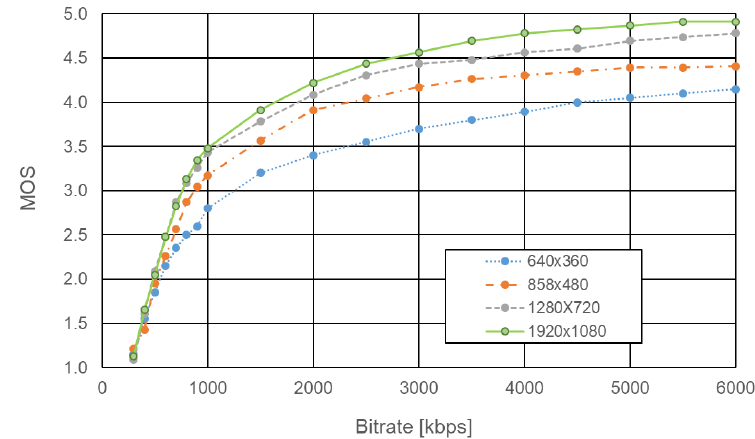
Figure 8. Results of the subjective quality assessment (MOS) for the H.265-encoded video as a func- tion of bit rate for different spatial resolutions—measurements at home.